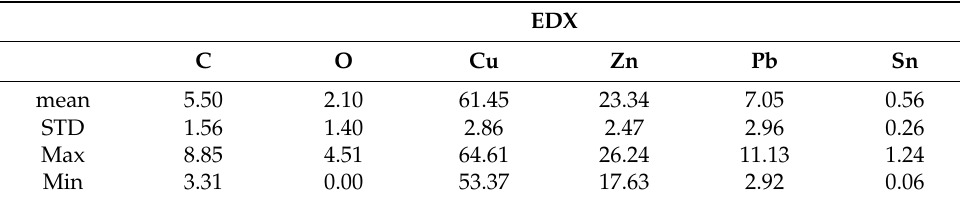
Table 3. Average chemical composition of the polished dark sample’s surface by EDX in